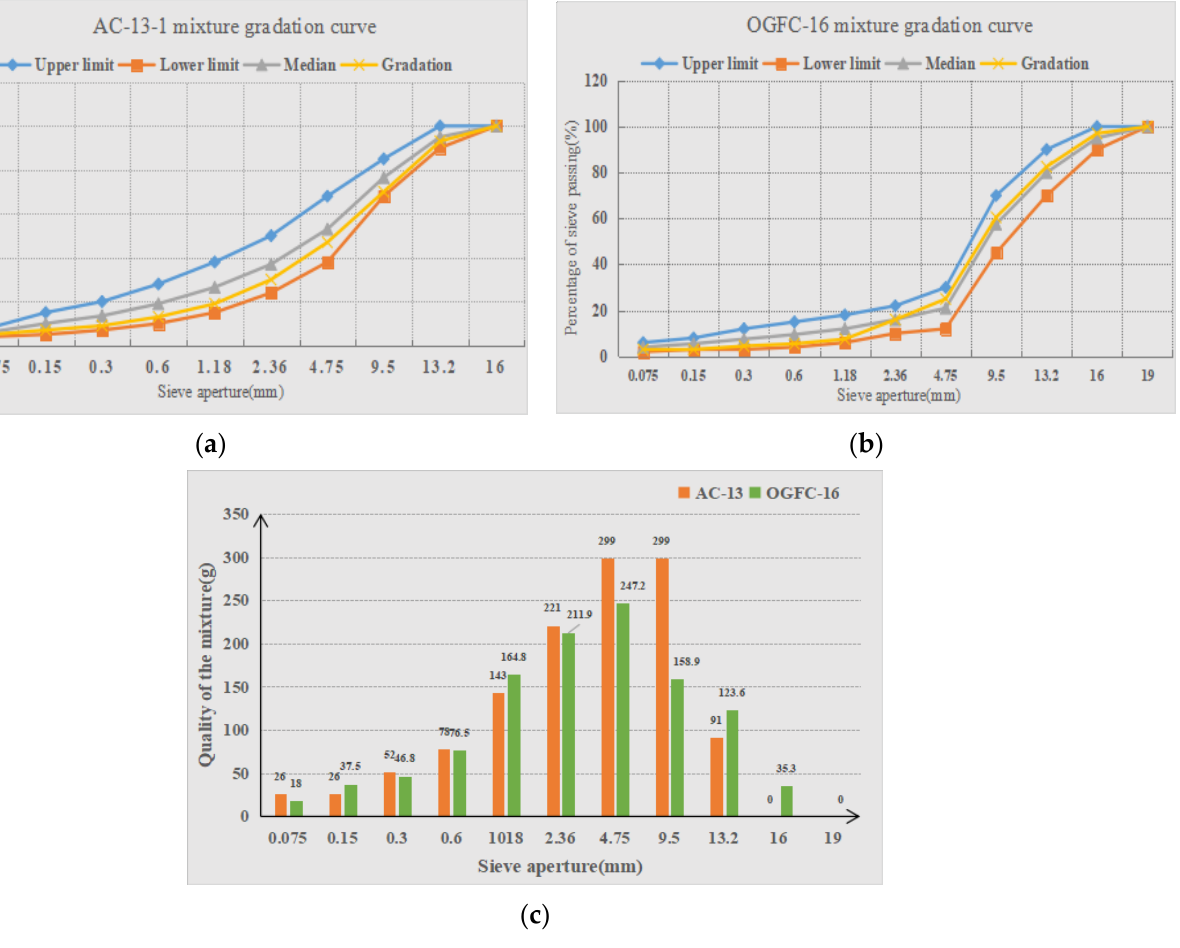
Figure 2. The gradation curves and the quality of the mixture. ( a ) AC-13-1 gradation curve. ( b ) OGFC-16 gradation curve. ( c ) Quality of the mixture.